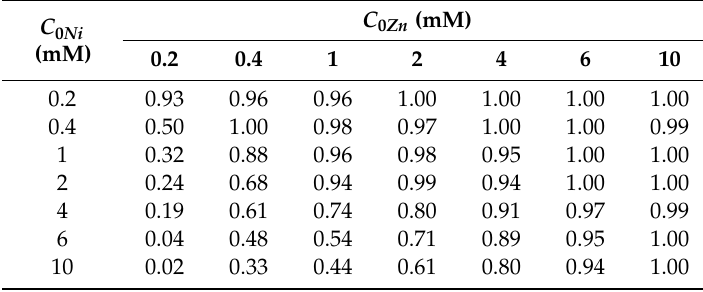
Table 4. The ratio of Zn 2 + biosorption capacity ( R qZn ) at di ff erent initial Ni 2 +